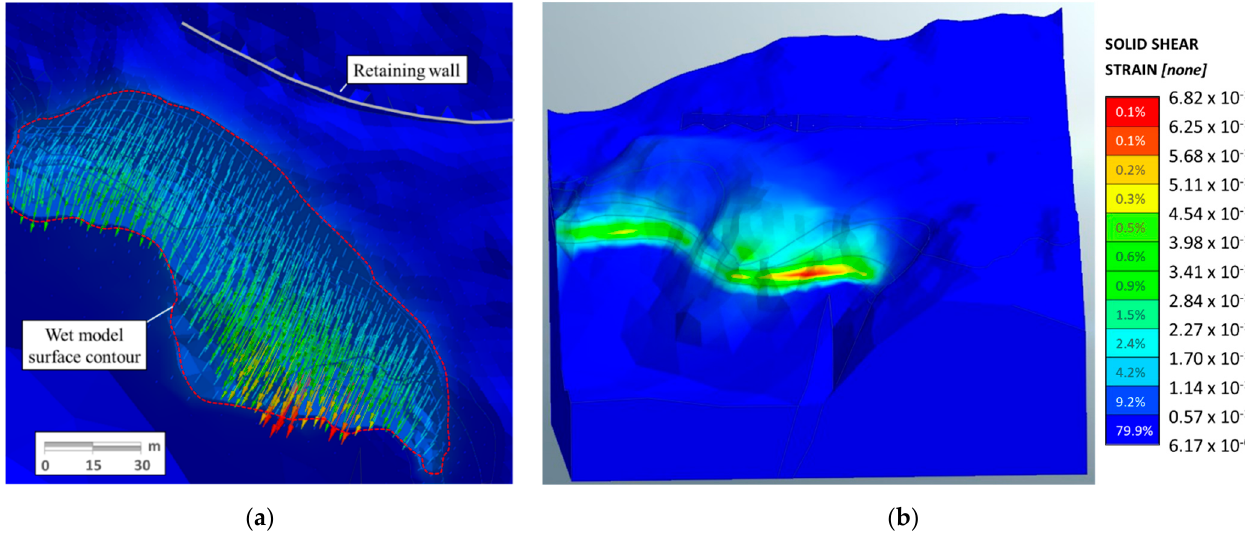
Figure 6. ( a ) Displacements vectors for the wet scenario (note that the scale used for the vector color is the same used in Figure 7a,b); ( b ) solid shear strain for the wet scenarios with FS max (Note that in the contour bar, the percentages represent the frequency of model nodes for each range of values).